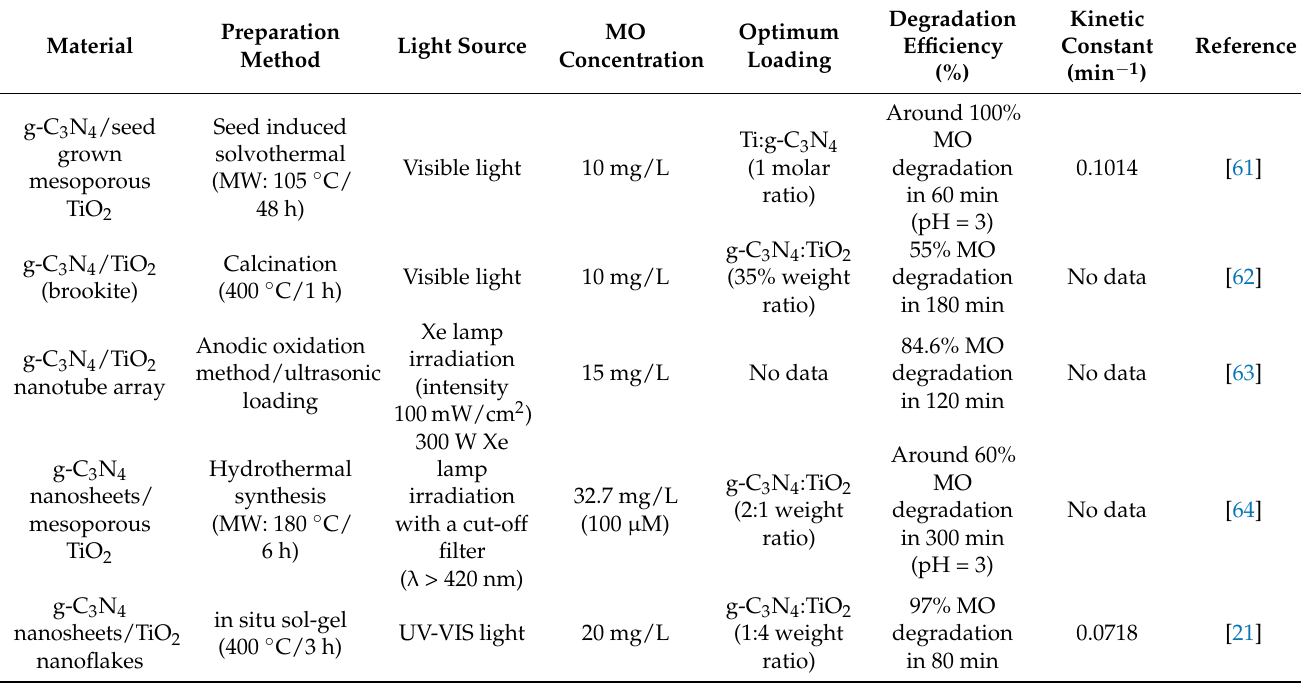
Table 1. Summary of g-C 3 N 4 /TiO 2 nanostructures reported in the literature for the degradation of MO using different preparation